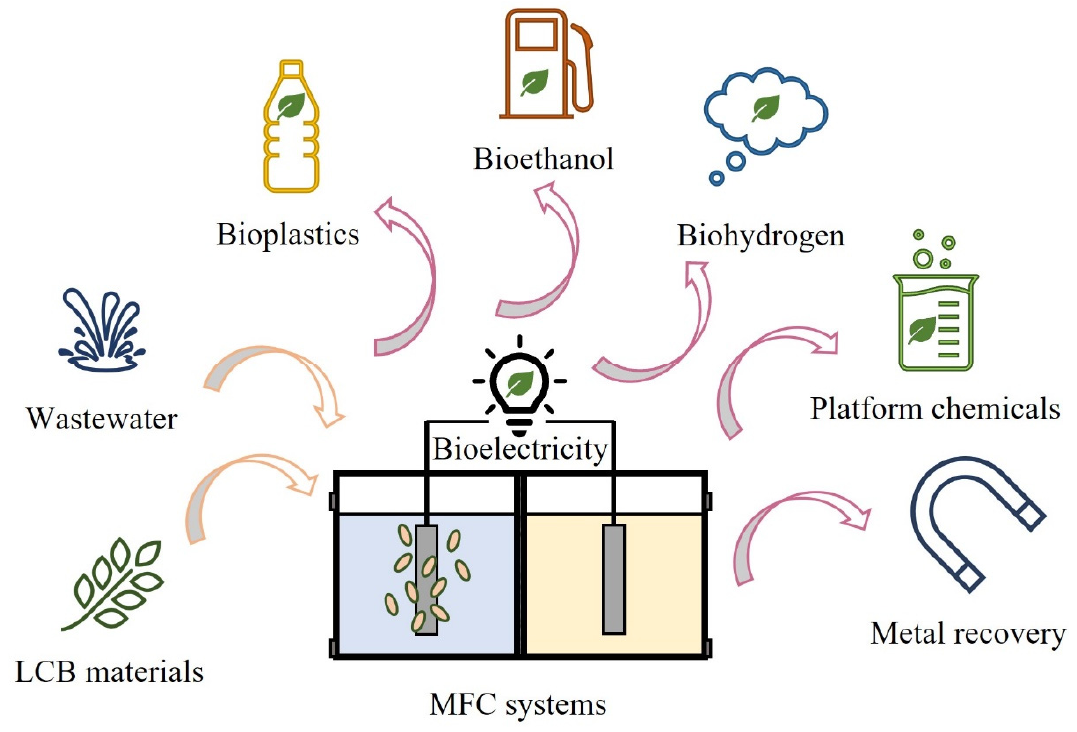
Figure 2. Waste valorization by MFC systems.